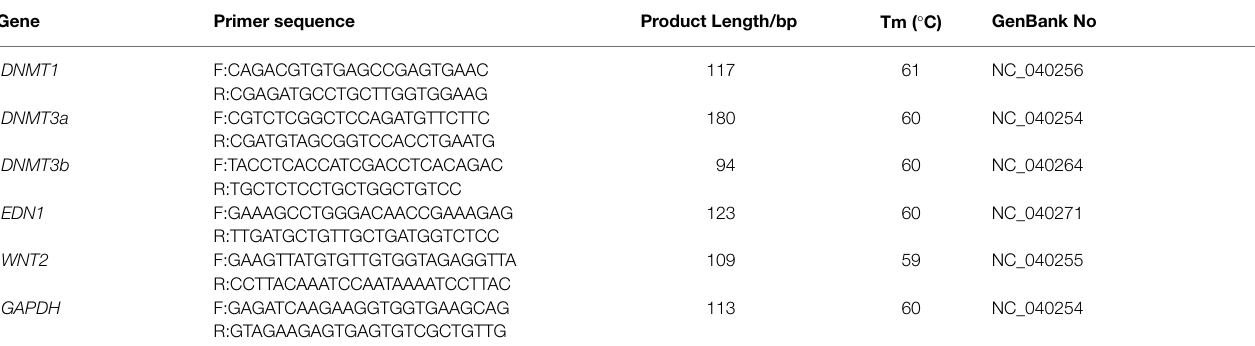
TABLE 4 | PCR primers of